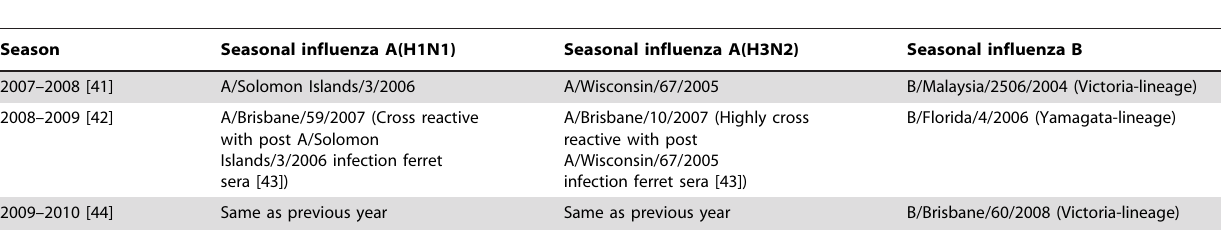
Table 1. Antigenic relationship between vaccine virus strains included in the trivalent inactivated influenza vaccines for the 2007– 2010 seasons (Northern Hemisphere).